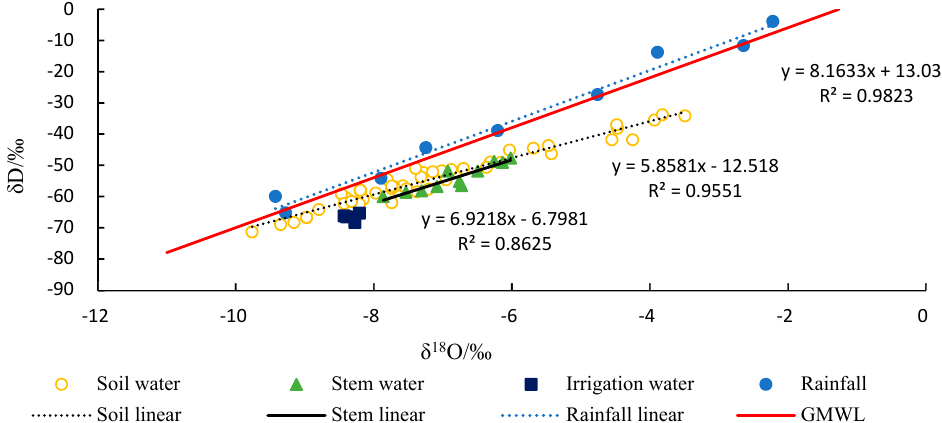
Figure 4. Distribution characteristics of hydrogen and oxygen stable isotope ratio ( δ D and δ 18 O) values of stem water and soil water.